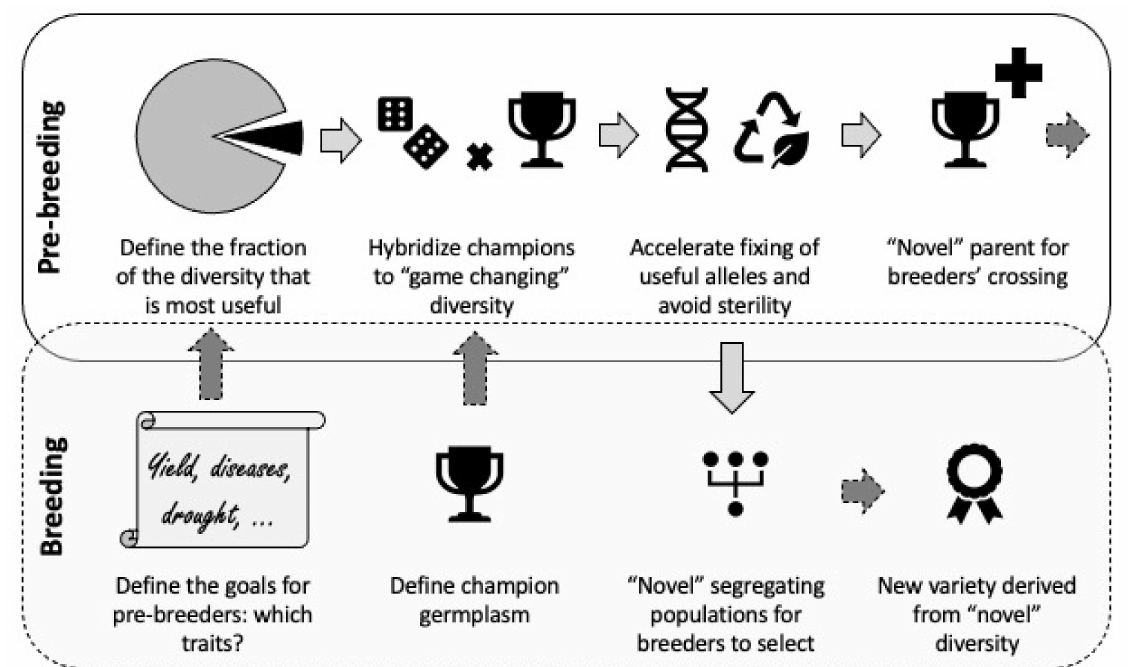
Figure 1. The key elements for a successful pre-breeding program are often simpler than one would expect. The key is to interact closely with breeders to provide the ready-to-use diversity that is truly useful for breeding efforts, and in return, receive the latest and best elite germplasm that can be used for